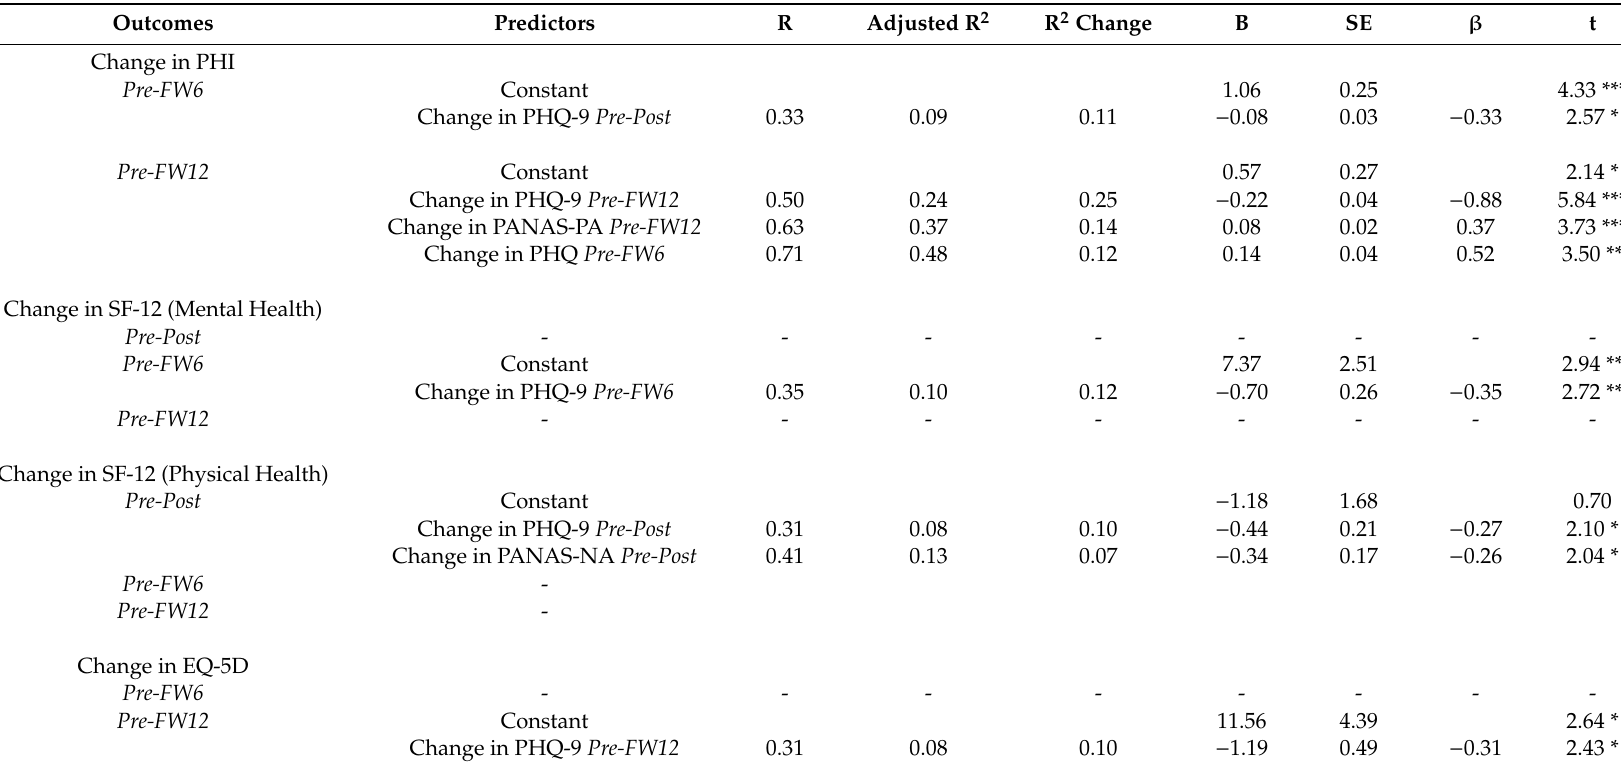
Table 6. Models for changes in depression severity (PHQ-9) and a ff ect (PANAS) as predictors of change in well-being (PHI), health-related quality of life (SF-12), and health status